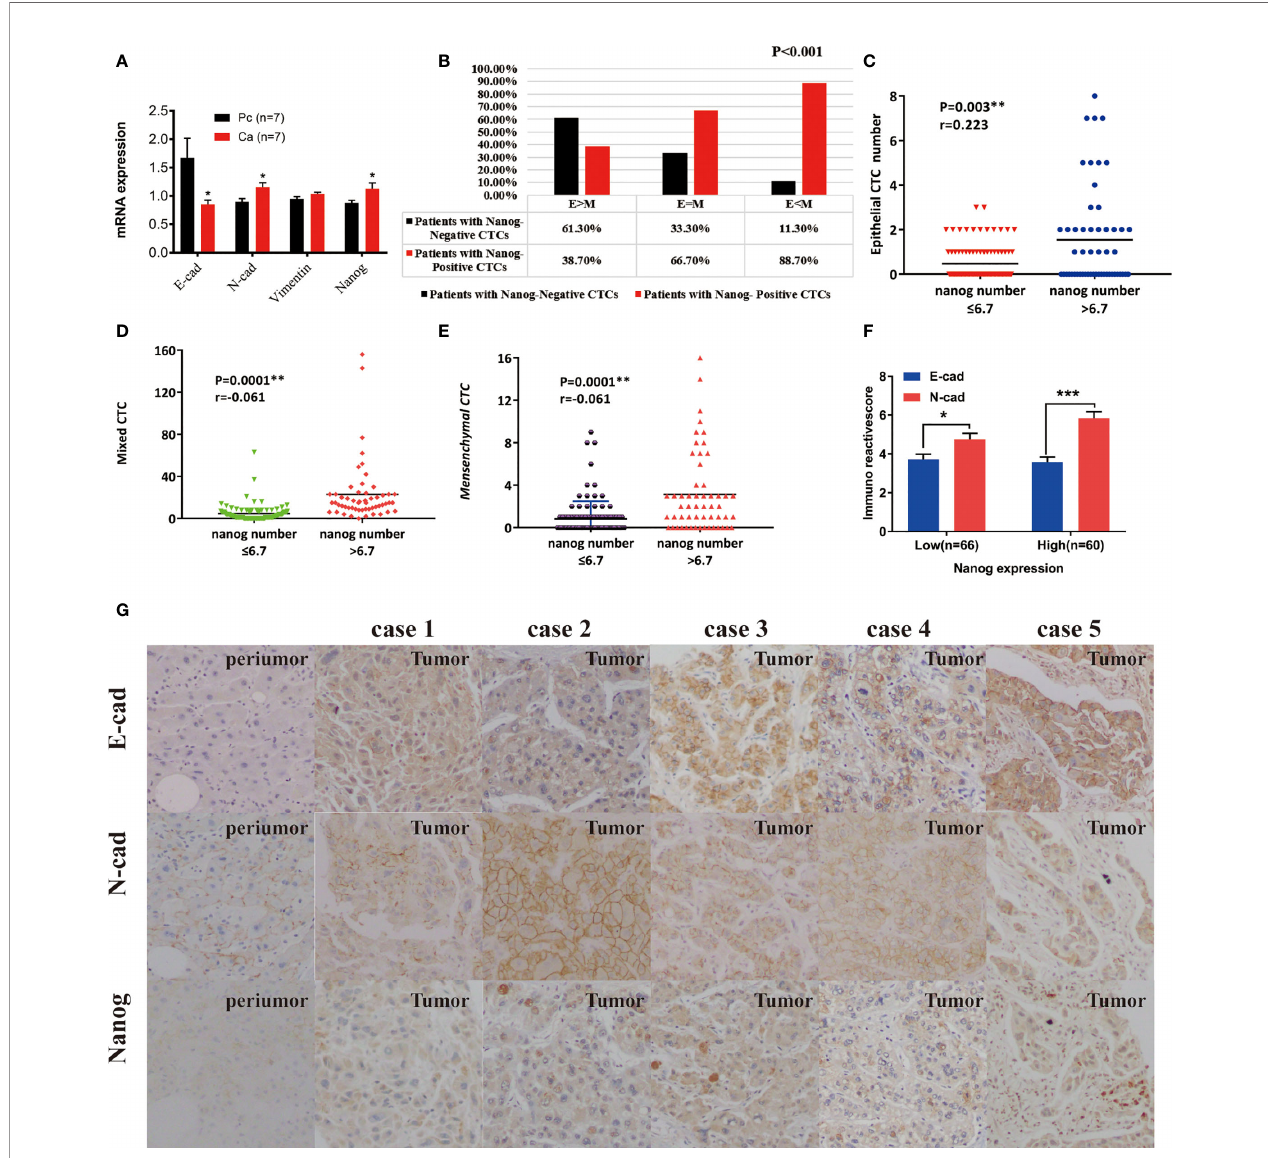
FIGURE 3 | The expression of Nanog and CTCs in liver cancer peripheral blood and clinical liver cancer tissues. (A) Expression differences of E-cadherin, N-cadherin, and Nanog in 7 pairs of cancer and adjacent tissues (*P < 0.05 , 2- △△ Ct). (B) The correlation between the phenotype of CTC and the Nanog positive rate in peripheral blood. (C – E) Correlation between phenotype and number of Nanog in peripheral blood. (F, G) Immunochemistry : Expression of E-cadherin, N-cadherin and Nanog in liver cancer tissues and their paired adjacent tissues (magni fi cation, ×100 and ×400). *** P <